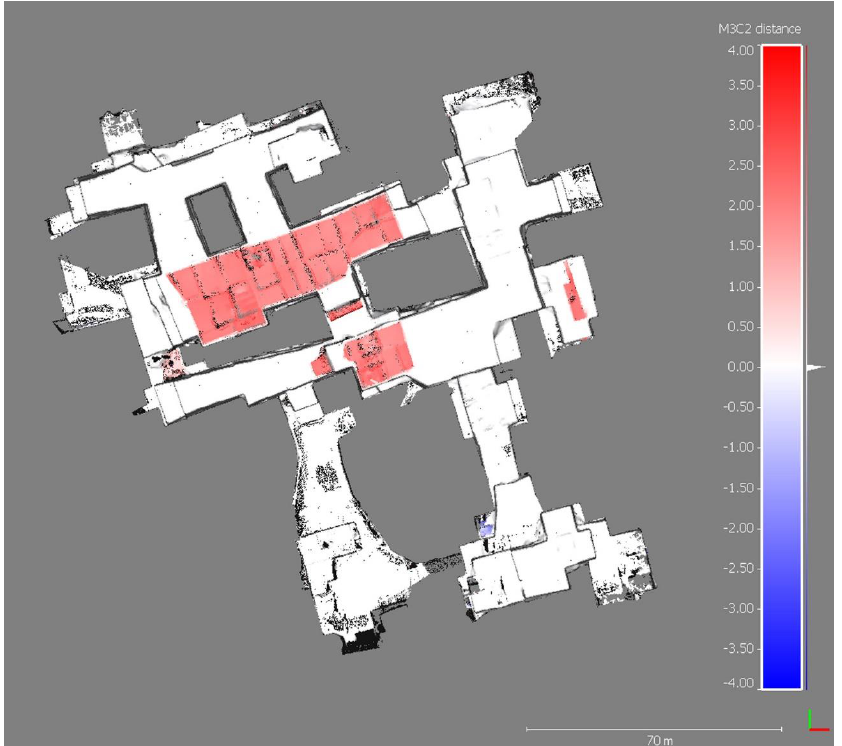
Figure 7. Map of computed distance to the closest corresponding point (the measurement unit of the Figure 7 color bar is